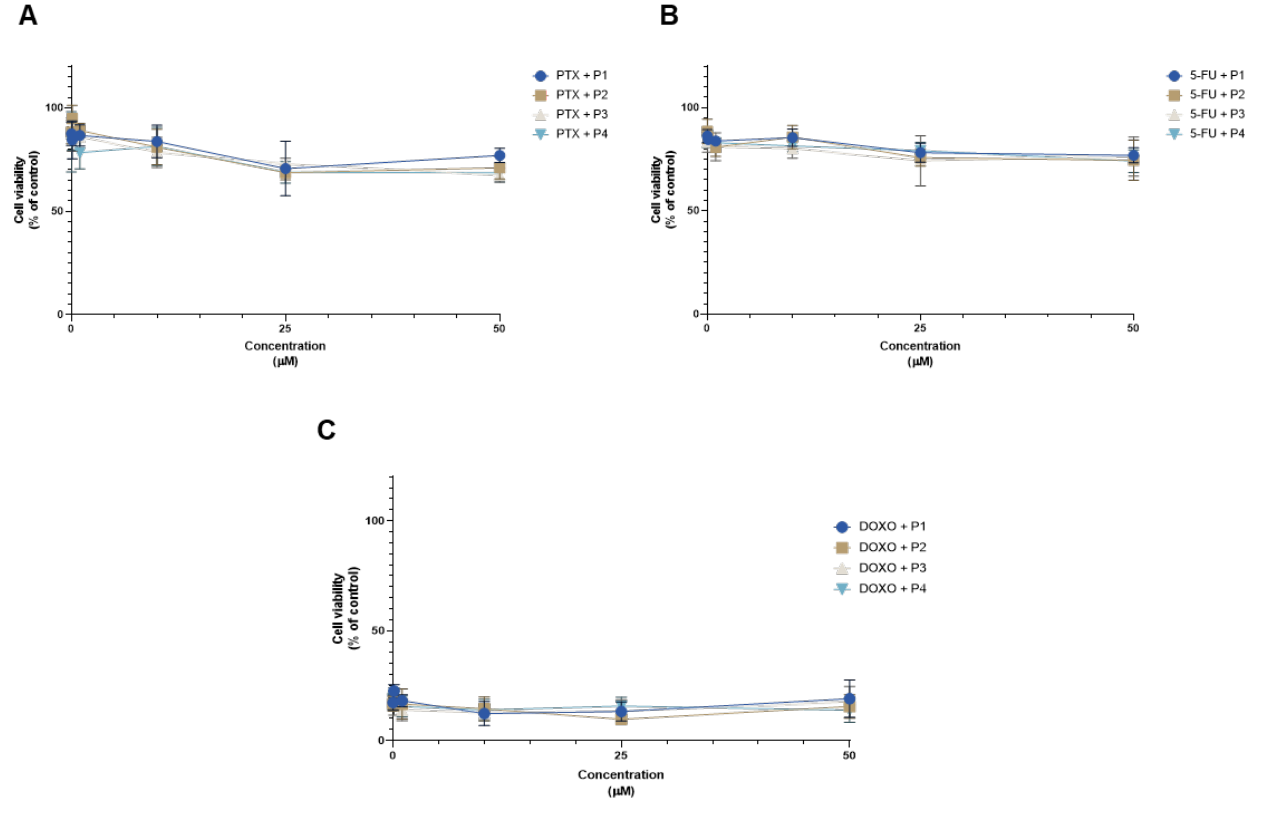
Figure 22. Comparison of the cell viability results of ( A ) MCF-7, ( B ) HT-29, and ( C ) PC-3 cells after exposure to combinations of chemotherapeutic drugs with increasing concentrations of the peptides P1 – P4 (0.01 – 50 μM) for 48 h. Control cells were treated with 0.01% DMSO (vehicle). Cell viability